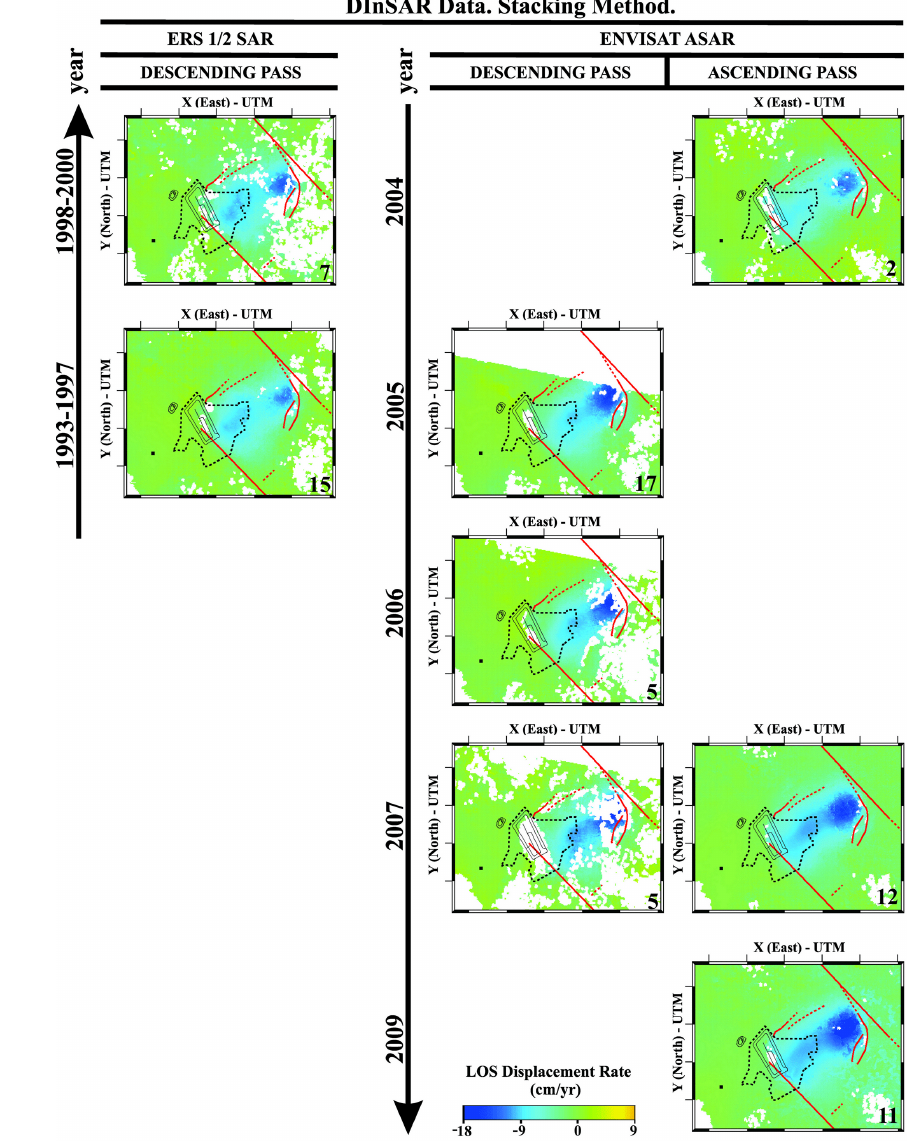
Figure 2. Maps of LOS displacement rate (cmyr − 1 ) showing the time evolution of the ground deformation field in and around the Cerro Prieto Geothermal Field in Mexicali Valley. Maps were obtained using the multiple Differential Interferograms Stacking (DIS) procedure. The numbers in the right lower corner indicate the number of differential interferograms used in stack. Negative displacement rates indicate an increase in the LOS range (ground subsidence). Black square marks the location of the reference, considered stable, region. Tectonic faults (solid and dotted red lines), CPGF limits (black thick dotted line), evaporation pond and CPV (thin gray lines) are superimposed onto the maps. The maps are in UTM coordinates, the marks are every